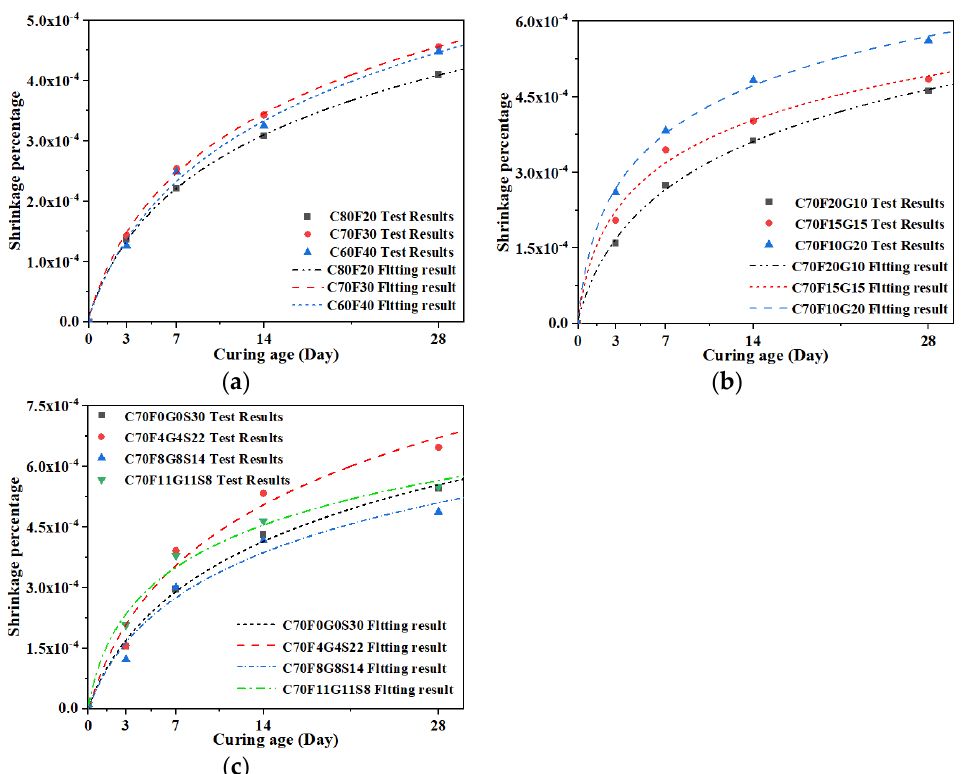
Figure 5. Early shrinkage of concrete. ( a ) Group FA early shrinkage; ( b ) Group GGBS early shrinkage; ( c ) Group SSP early shrinkage.